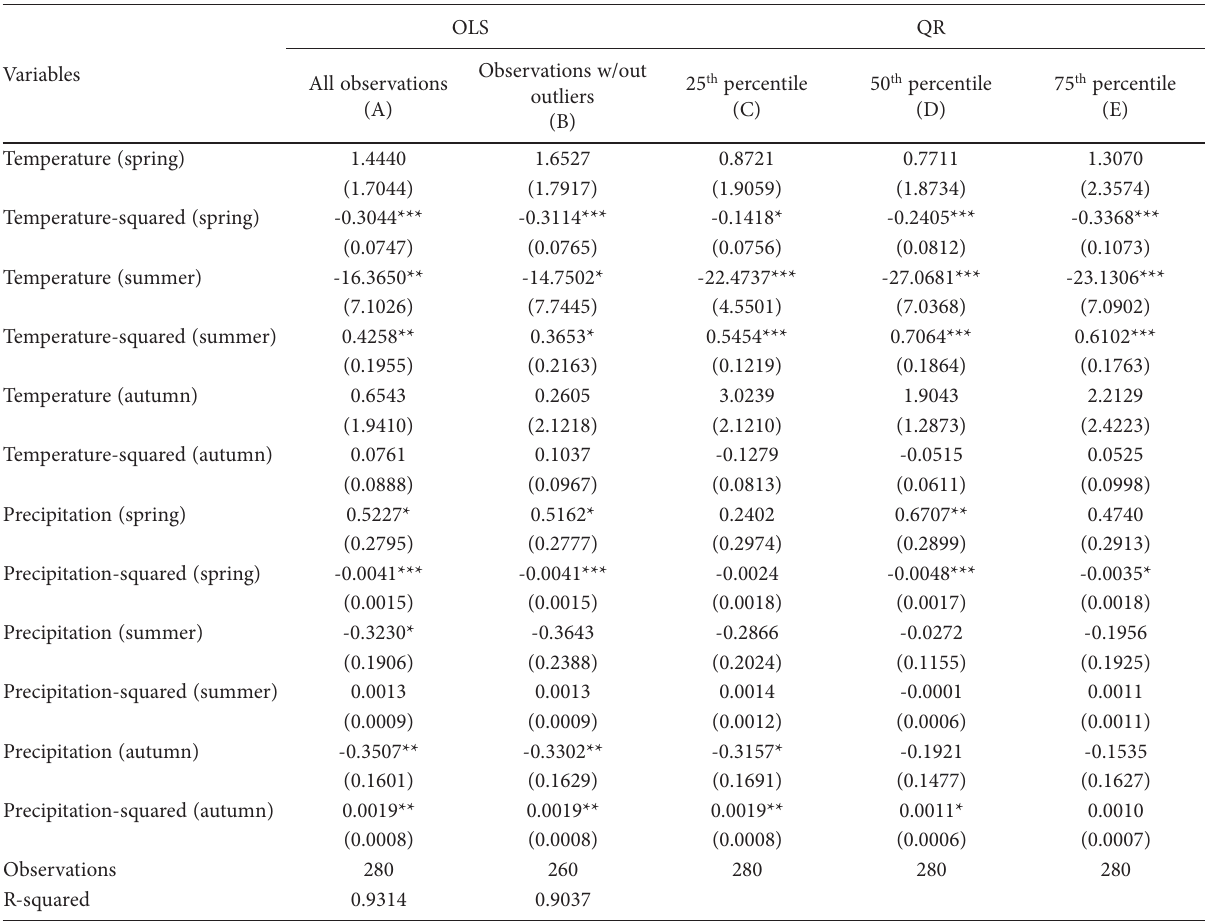
Table A.7. Estimation results for grapevines yields: OLS with and without outliers and QR.